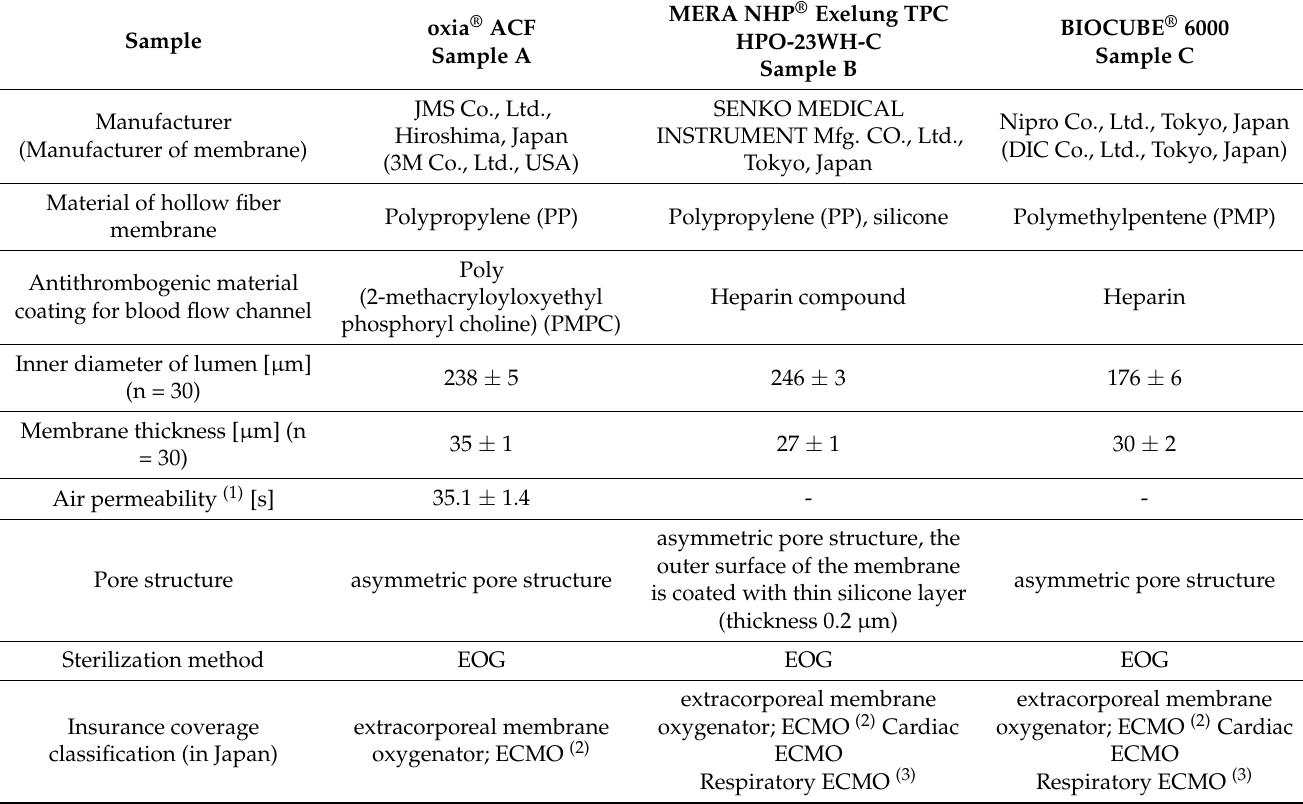
Table 1. Specification of hollow fiber membranes for membrane